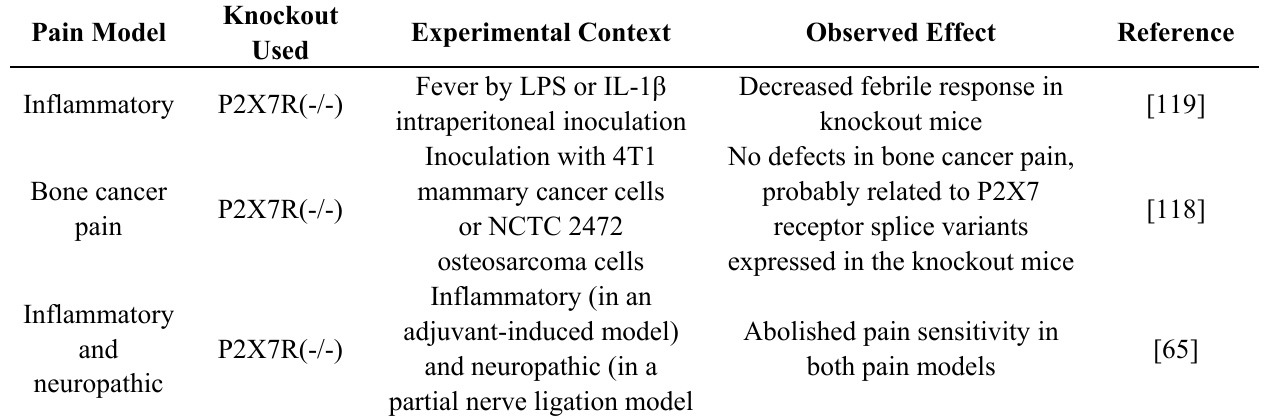
Table 1. Pain disorder responses in P2X7R KO mice